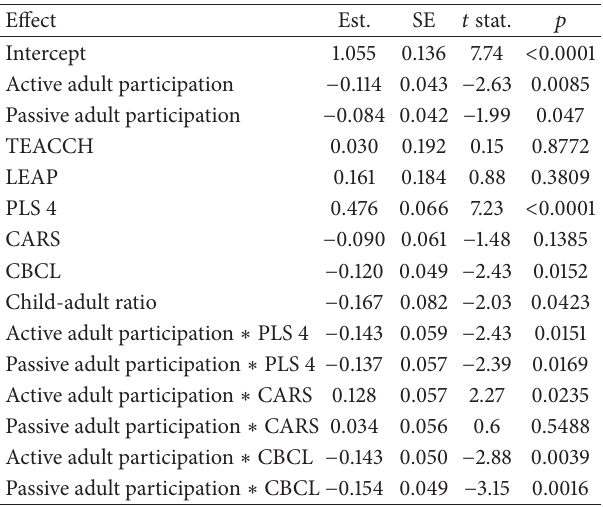
Table 5: Model 2 results for moderators of relationship between child engagement and adult participation.